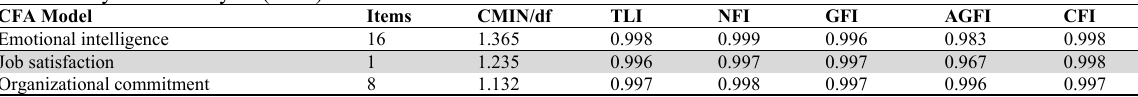
Confirmatory factor analysis (CFA) of all measurement models